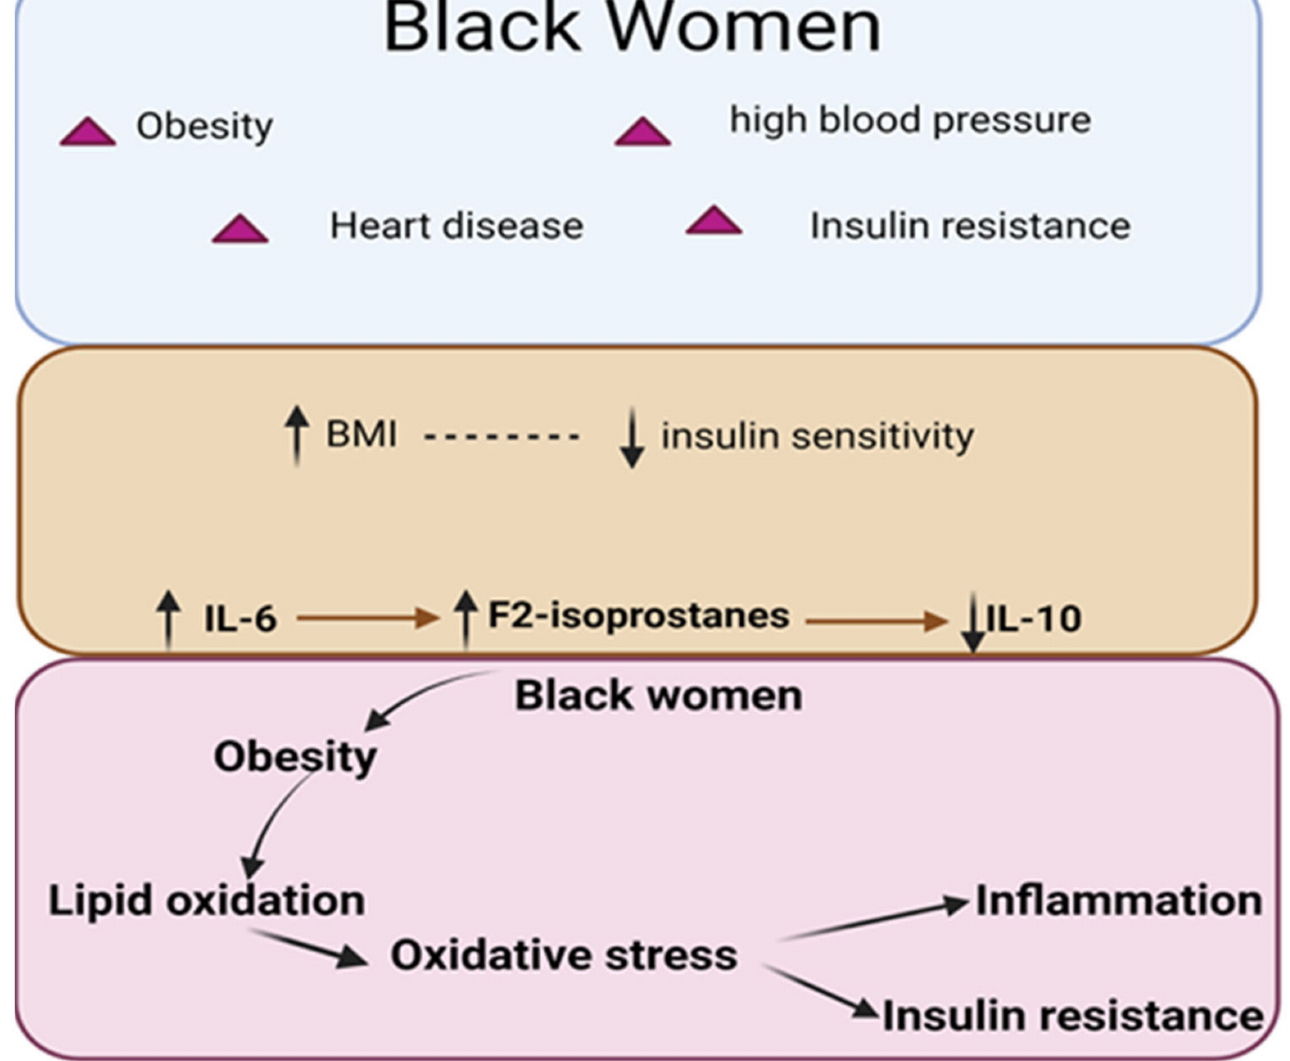
Figure 7. Graphical summary of the study. Eighty-eight obese Black women were recruited in this study. Pearson’s correlation analysis revealed a positive correlation between obesity and re- duced insulin sensitivity and increased F2-isoprostanes. F2-isoprostanes positively correlated with proinflammatory interleukin-6 (IL-6) while negatively correlated with interleukin-10